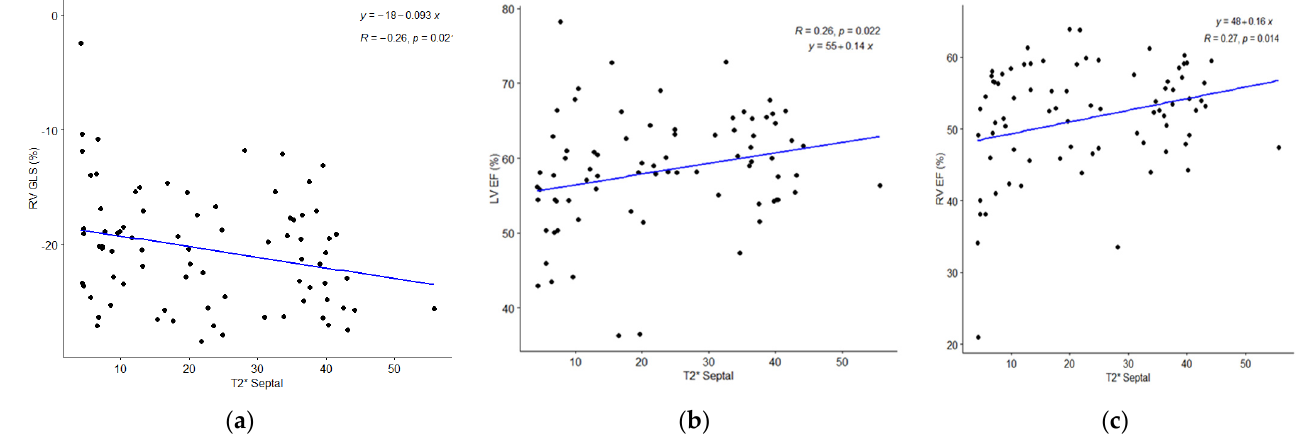
Figure 2. Depicts the relationship between T2*Septal measurements and the RV GLS, LV, and RV Ejection Fractions using a scatter plot. ( a ) RVGLS; ( b ) LVEF; ( c ) RVEF.